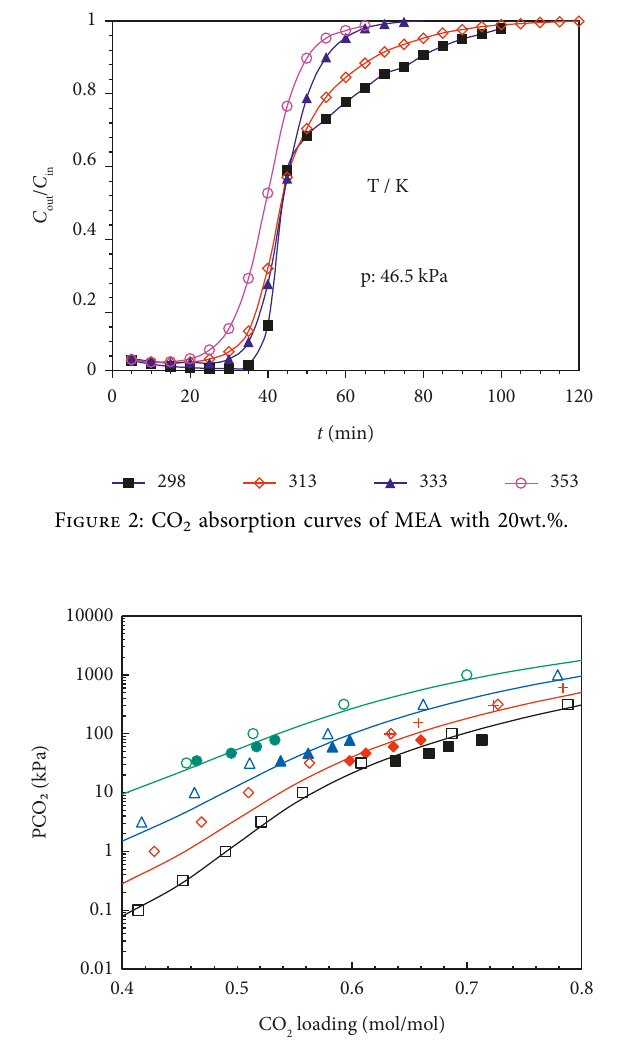
Figure 3: Comparison of the experimental data (symbols) for CO 2 partial pressure of MEA-H 2 O-CO 2 system and the model results (lines), 20 wt.% MEA. Full symbols: experimental data from this work; − 313K, Wong et al. [25]; − 298K, -313K, Δ − 333K, − 353K Lee et al. [43]. Table 3: Values of K 8 and K 9 in 20 wt. % aqueous MEA solution. Temperature, K K 8 , (mol/L) K 9 , (mol/L) 0